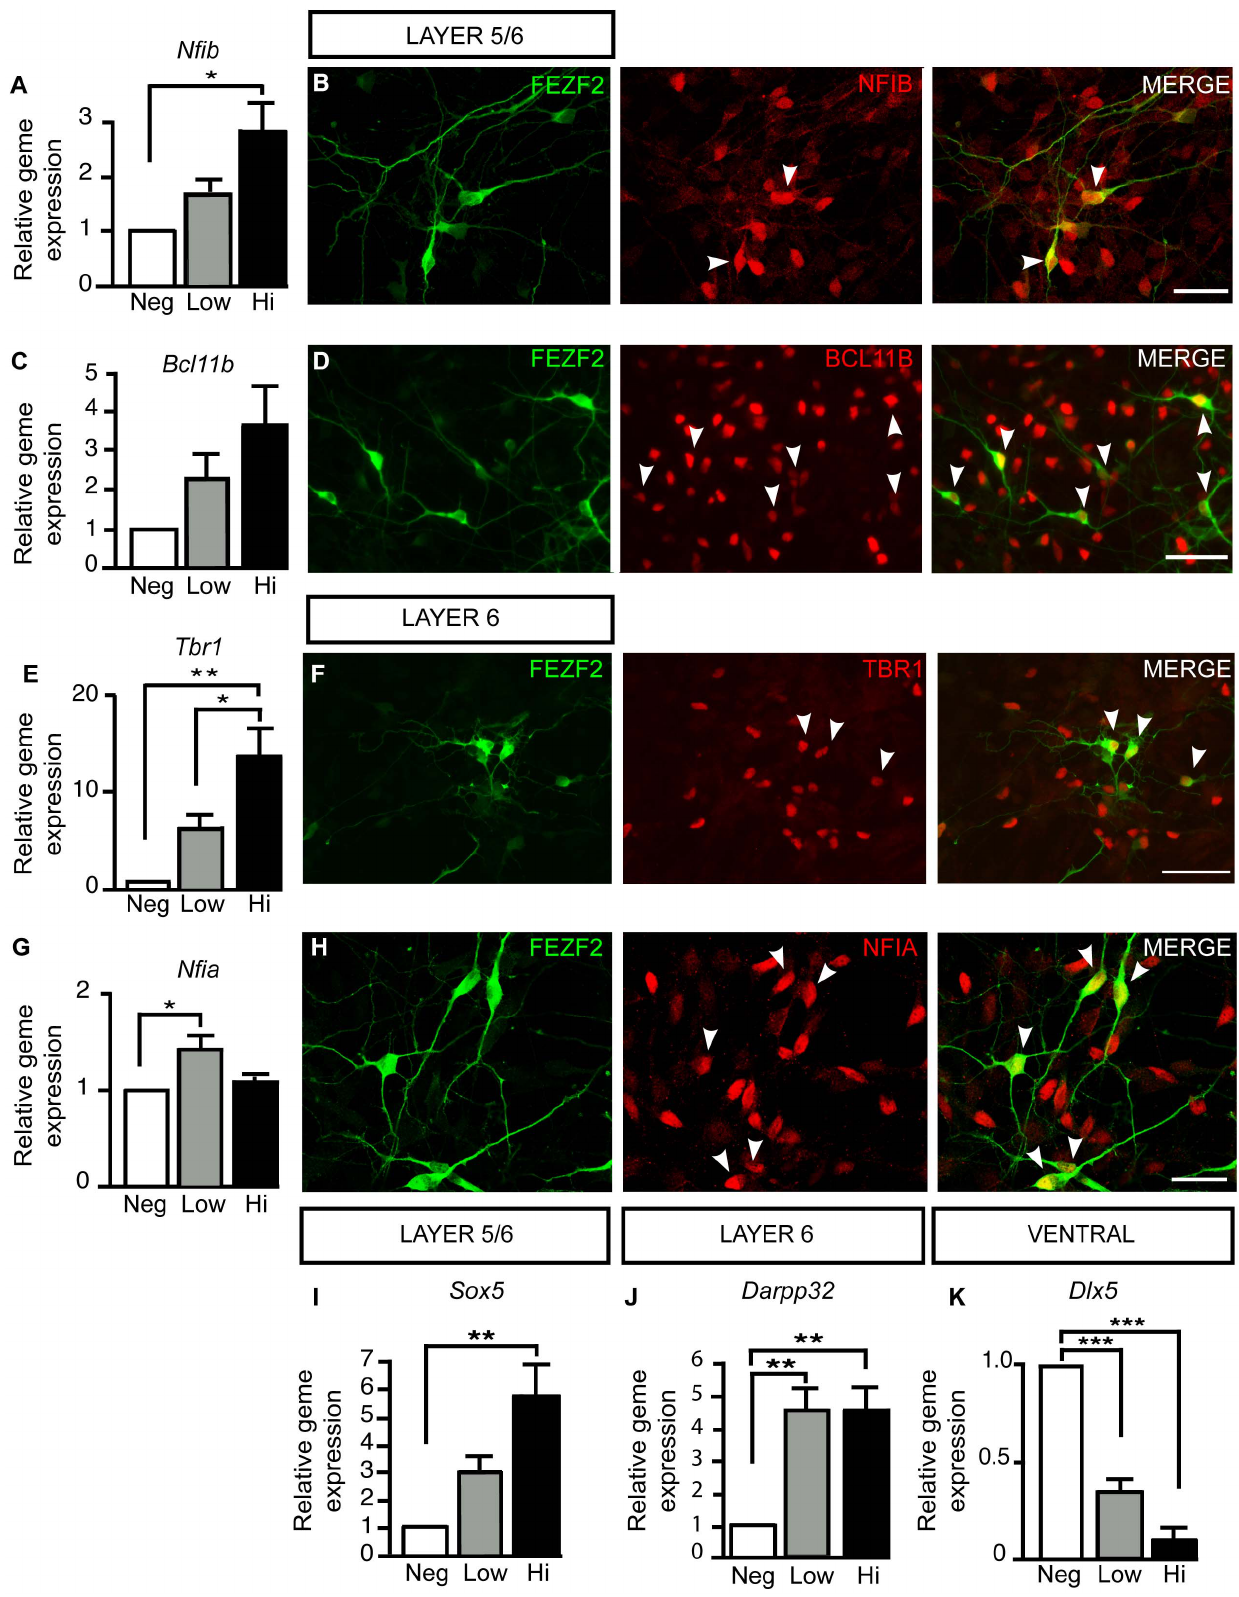
Figure 7. Differentiated h Fezf2- YFP Hi and h Fezf2- YFP Low cells express corticofugal neuron markers. ( A ) Quantitative RT-PCR analysis for Nfib mRNA expression on sorted h Fezf2 -YFP subpopulations (F(2,6)=7.405; p=0.0240). ( B ) Immunofluorescence staining showing NFIB expression in differentiated h Fezf2 -YFP + cells at day 35. ( C ) Quantitative RT-PCR analysis of Bcl11b mRNA expression on sorted h Fezf2 -YFP subpopulations. ( D )